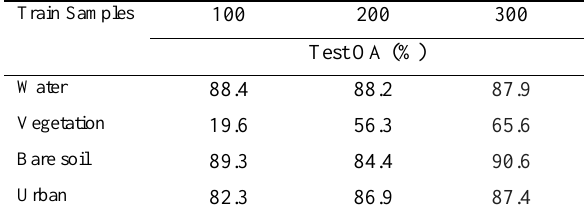
Table 3. Obtained classification results of every class for